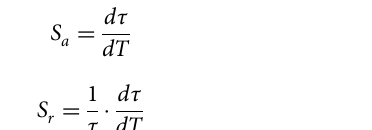
Furthermore, the absolute temperature sensitivity ( S a ) and relative temperature sensitivity ( S r ) based on the luminescence lifetime of Er 3 + are calculated according to the following equations (Fig. 6b), respectively: 47